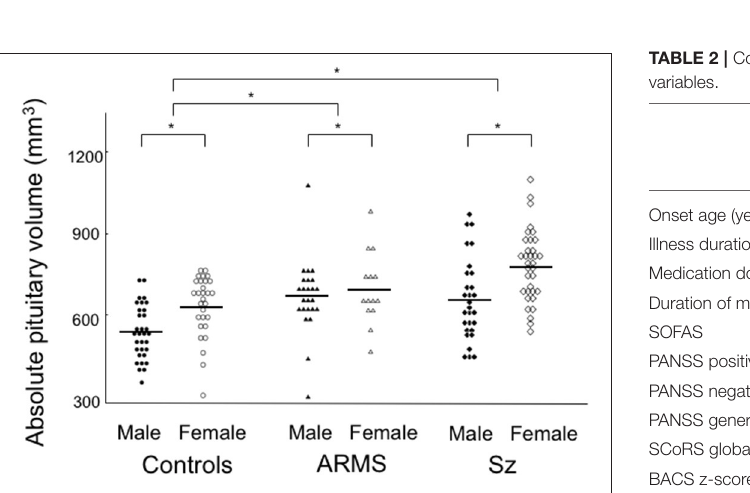
FIGURE 2 | Absolute pituitary gland volume in the subjects with at-risk mental state (ARMS), patients with schizophrenia (Sz), and healthy controls. Horizontal lines indicate mean values. post-hoc test: * p < 0.01.